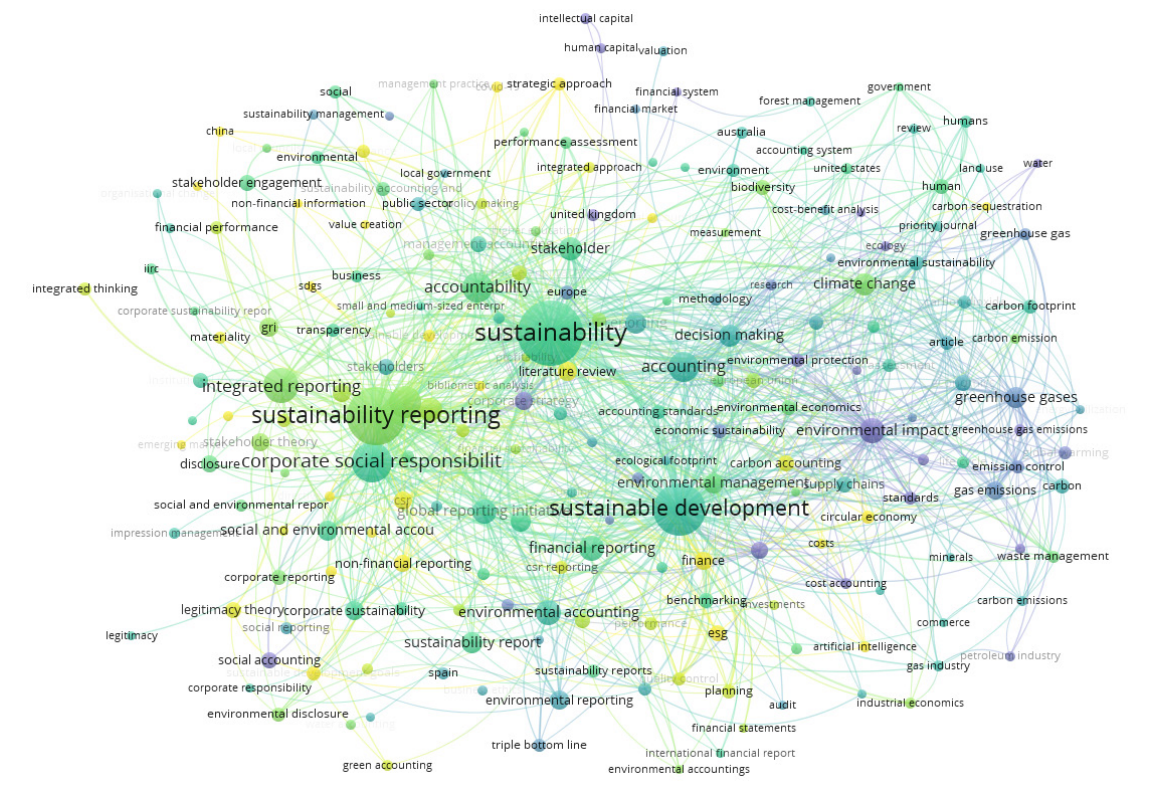
Figure 4. Visualization map of the context-time dimension of research on “sustainability reporting” published in the editions of the Scopus